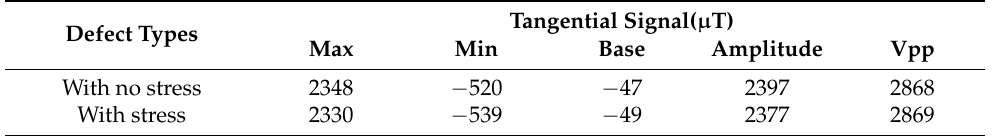
Table 1. Characteristic strength of tangential